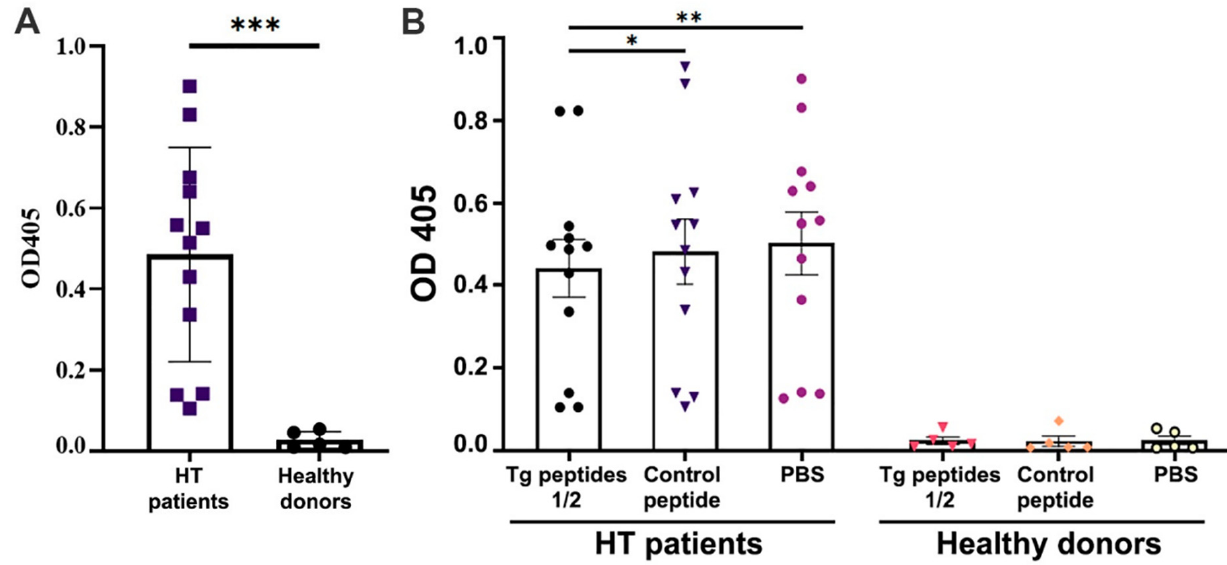
Figure 2. The thyroid gland lysate and Tg peptide epitopes are recognized by anti-Tg IgG antibodies from HT patients. ( A ) Autoantibodies in sera from HT patients recognized the thyroid gland lysate by ELISA. ( B ) ELISA assay for peptide epitopes recognition by antibodies in the individual sera from HT patients (left) and healthy donors (right). The sera were preincubated with Tg1/Tg2 peptides mix or with Control peptide and later incubated in 96-well plates loaded with thyroid gland lysate. All assays were performed in triplicate and the average values were used for analysis. Mean ± SD values were calculated for each group; p values were calculated ( n = 12 for HT patients and n = 5 for healthy donors) (* p < 0.05, ** p < 0.01, *** p < 0.001) in comparison to sera preincubated with PBS only.